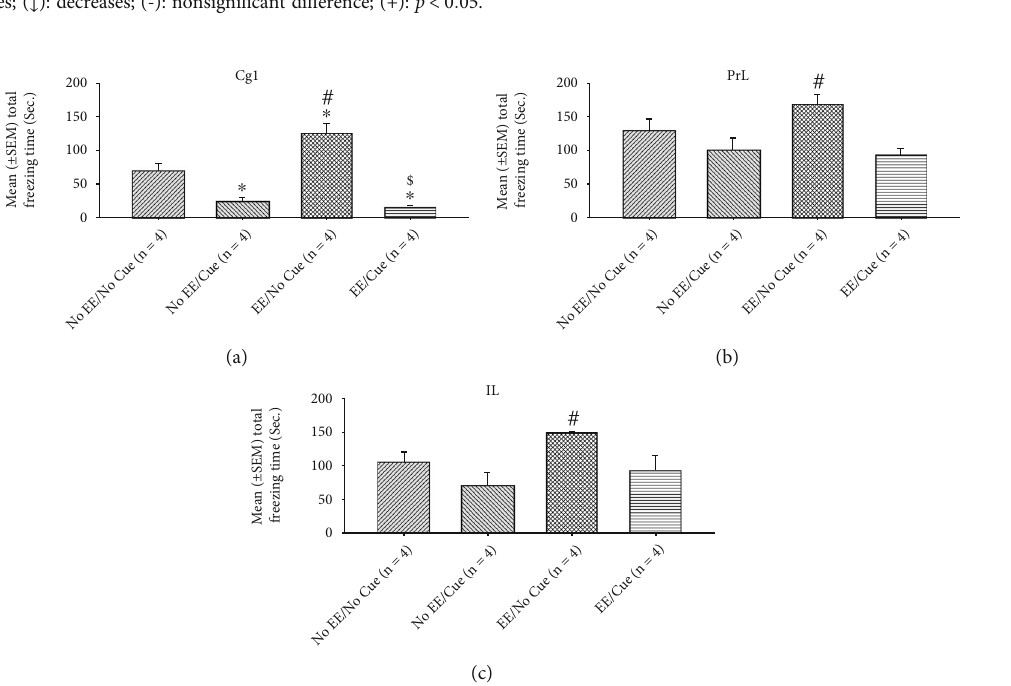
Figure 7: Mean ( ± SEM) c-Fos expression in the Cg1 (a), PrL (b), and IL (c) for the no EE/no cue ( n = 6 ), no EE/cue ( n = 6 ), EE/no cue ( n = 6 ), and EE/cue groups ( n = 6 ). EE: environmental enrichment. ∗ p < 0 : 05 indicates signi fi cant di ff erences compared to the no EE/no cue group; # p < 0 : 05 indicates signi fi cant di ff erences compared to the no EE/cue group.